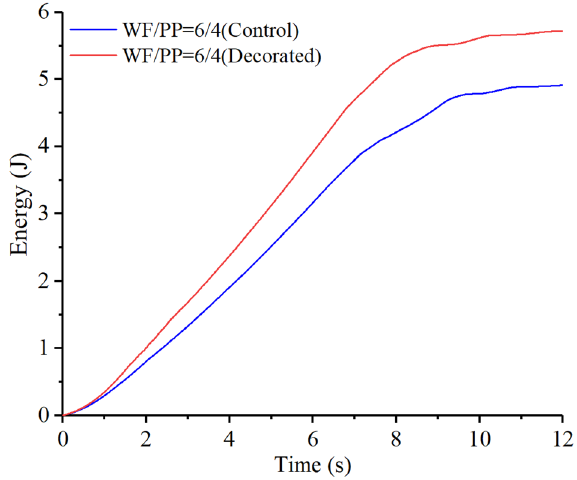
Figure 18. The drop hammer strain energy-time curve of the WF/PP = 6/4 specimen.